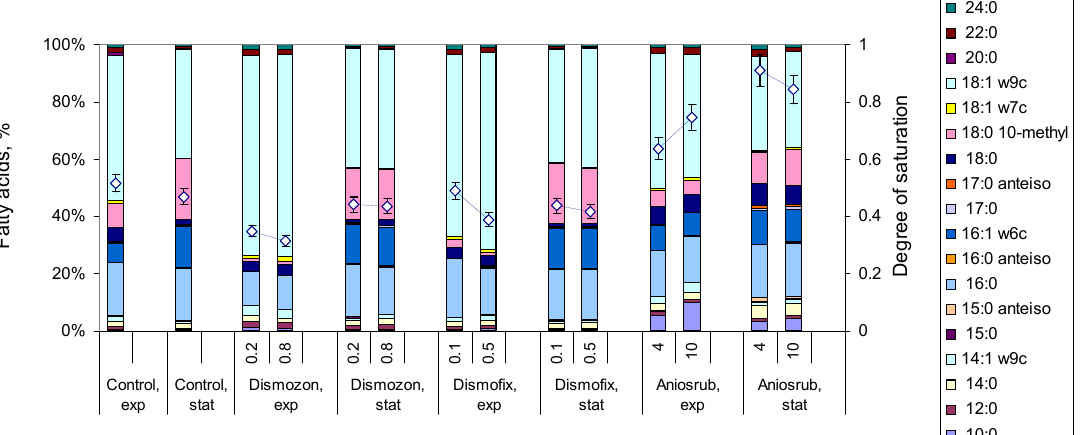
Figure 2. Fatty acid composition of M. vaccae cells exposed for 6h to disinfectants during exponential (exp) and stationary (stat) growth phases. Only FA accounting for at least 1% of total lipids are represented. The content of each fatty acid presented here may be found in Table S2.